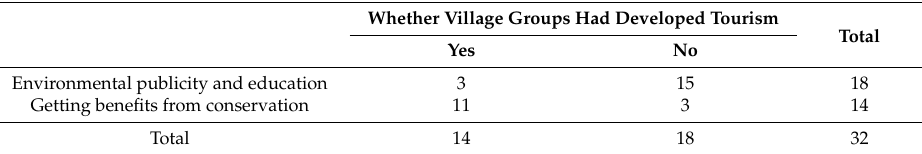
Table 6. Contingency table between tourism groups and willingness for protection.